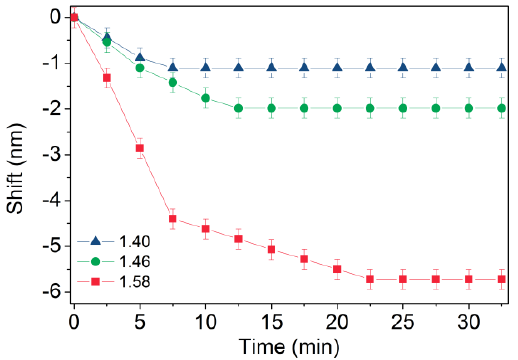
Figure 3. Wavelength shift versus immersion time in the oily sample, of the 1563 nm notch of the FP resonator for three oils with the lowest refractive indices from the series AA, A1 and A2. The error bars present the resolution of the optical spectrum analyzer during the recording of the measurements.